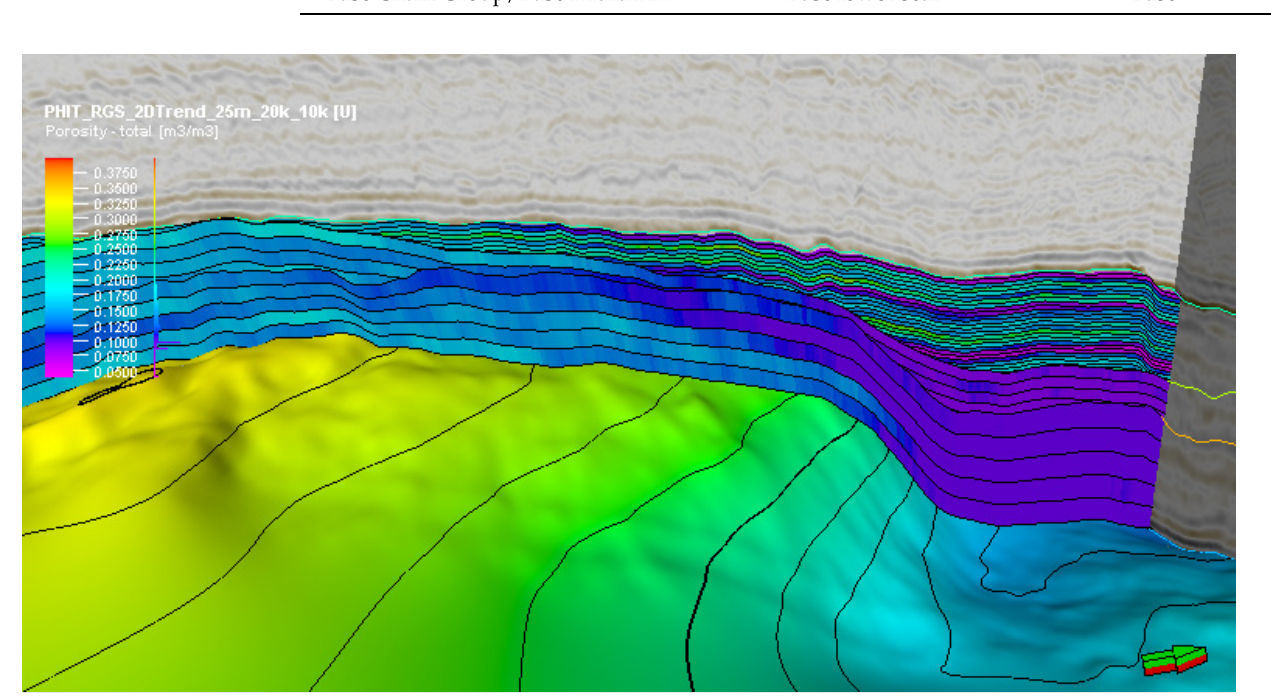
Figure 5. N–S extracted section through the 3D static model and the wedged chalk prospect, with modeled porosity values. Note that the reservoir units have a finer layering and the highest porosities, and they pinch out to the south. Note also the decrease in porosity in the deeper northern part of the model as a result of increased burial compaction.